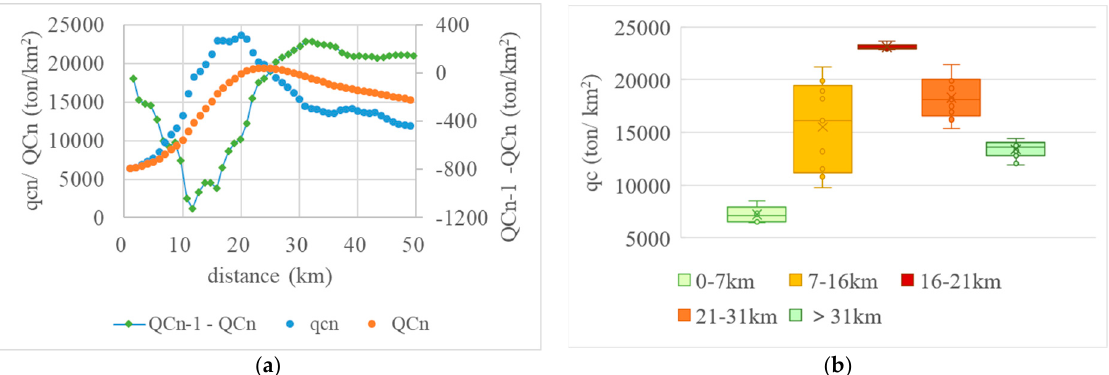
Figure 9. Variation in CDEI for Nanjing. ( a ) Scatter plot of CDEI; ( b ) Box plot of CDEI.